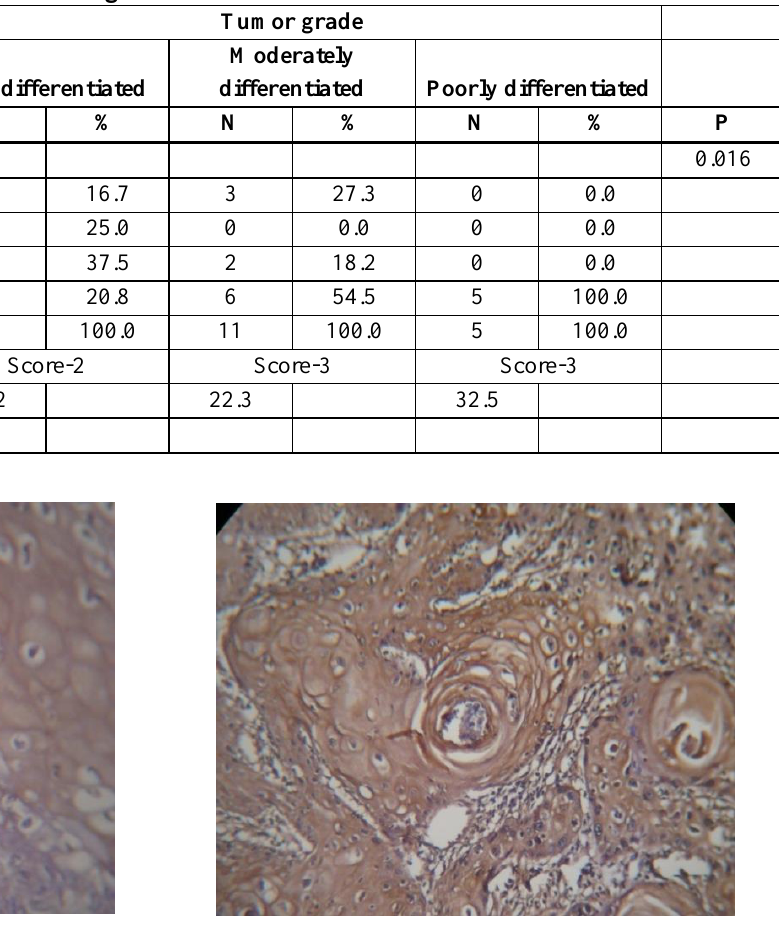
Figure (1): Membranous and cytoplasmic Figure (2):Membranous and cytoplasmic NRP1 expression in OSCC (X40) NRP1expression in LSCC (X20)